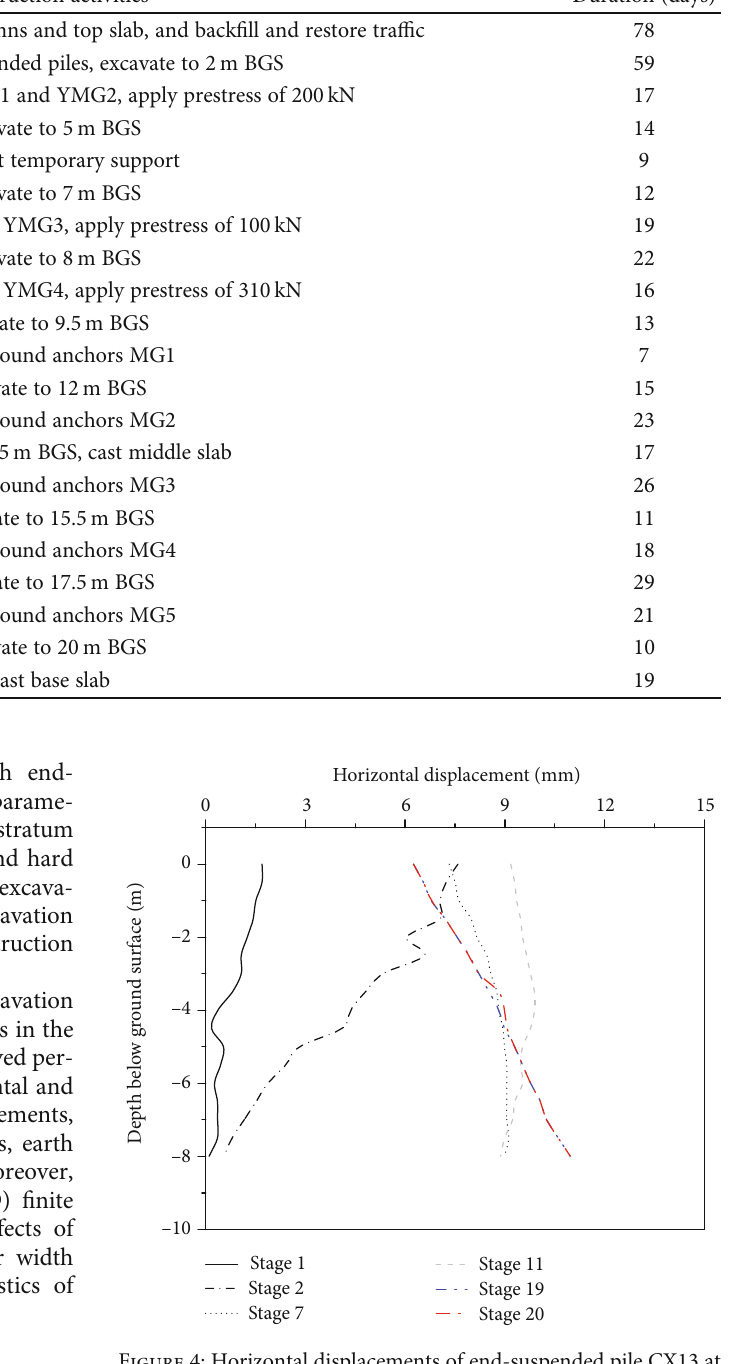
Figure 4: Horizontal displacements of end-suspended pile CX13 at various construction